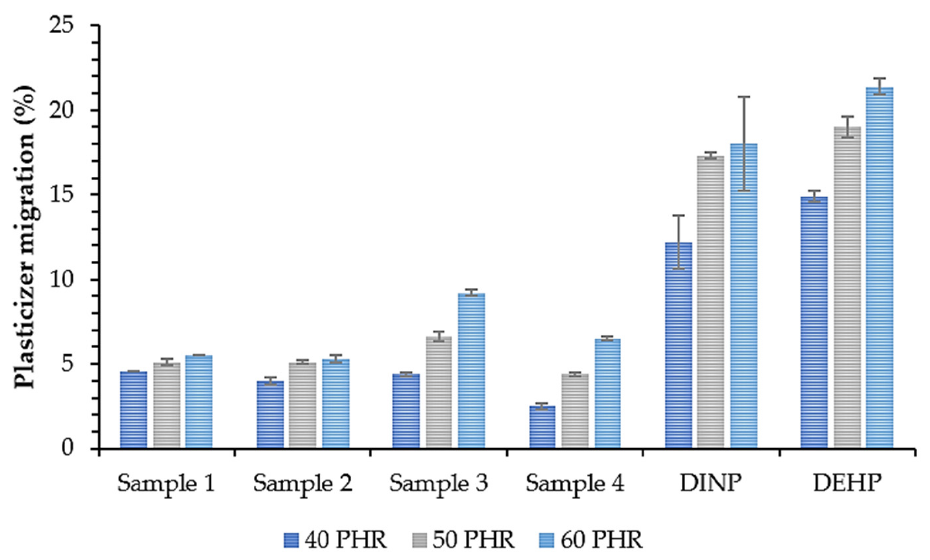
Figure 11. Plasticizer migration from soft PVC samples.